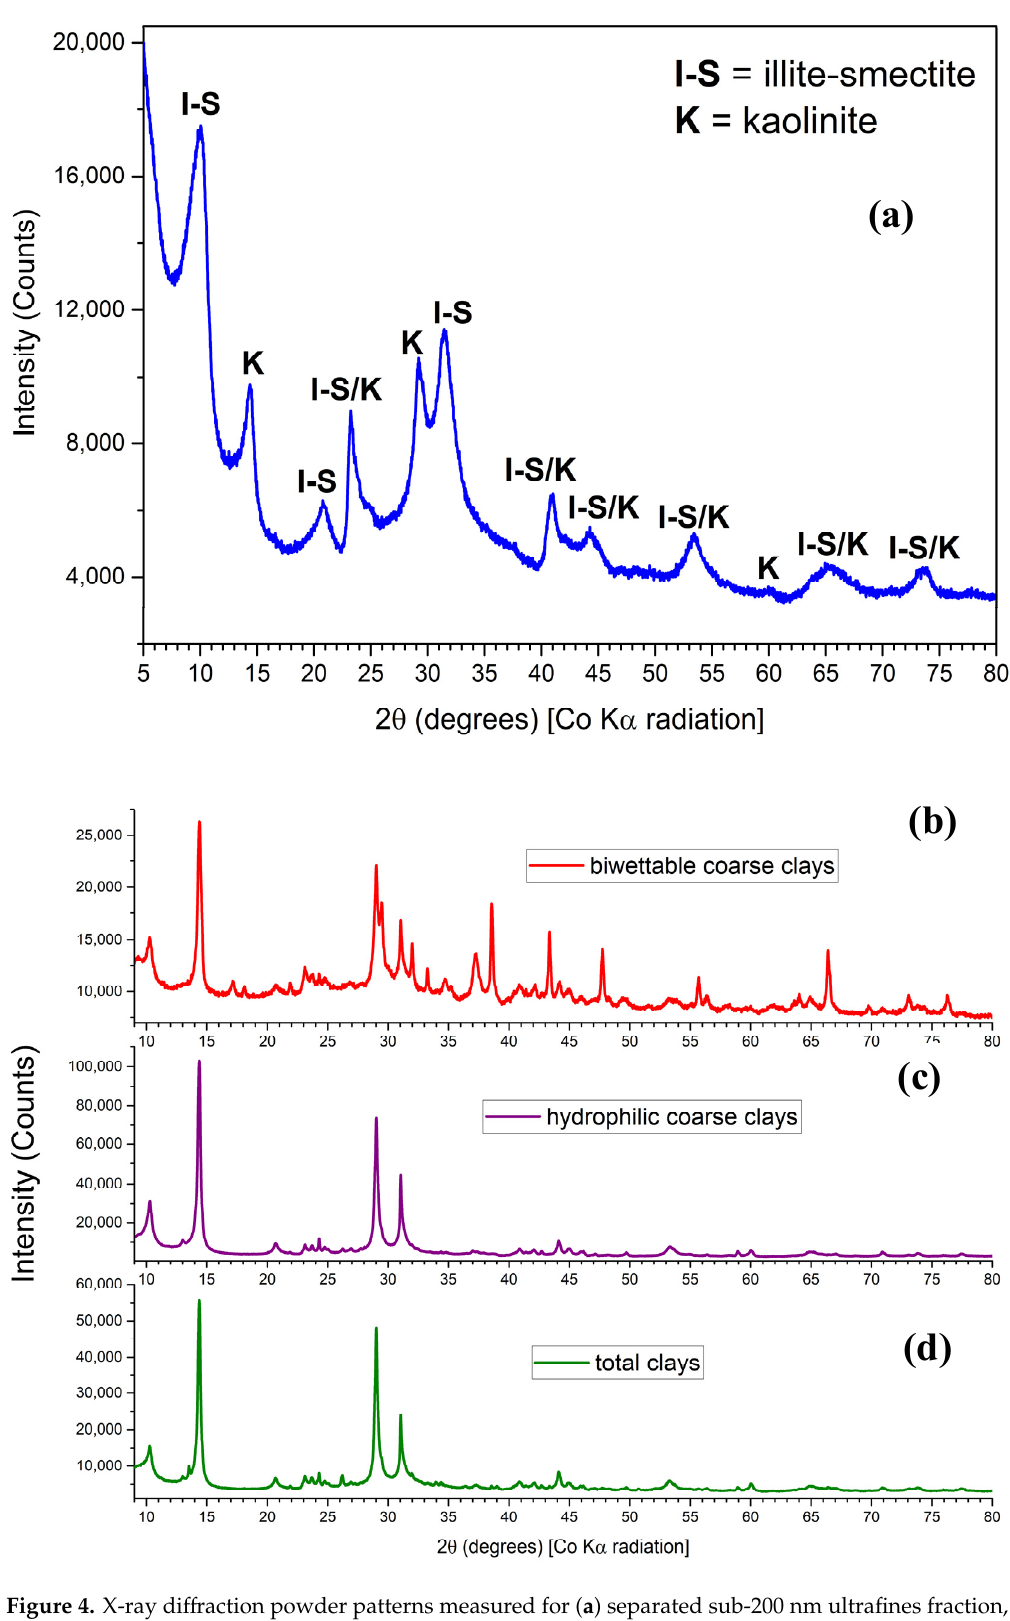
Figure 4. X-ray diffraction powder patterns measured for ( a ) separated sub-200 nm ultrafines fraction, compared to those obtained for ( b ) biwettable and ( c ) hydrophilic coarse clays (0.2–2 µm), and ( d ) total clays (<2 µm)